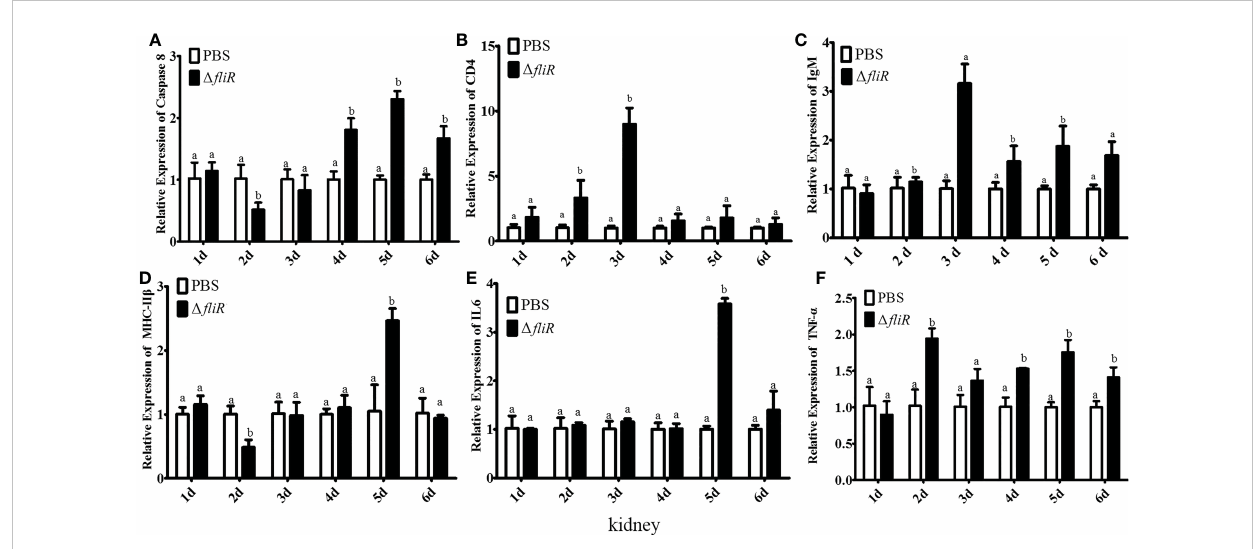
FIGURE 10 The expression levels of immune-related genes in grouper kidney after immunization were detected by qRT-PCR for (A) Caspase8 , (B) CD4 , (C) IgM , (D) MHC-II b , (E) IL6 , (F) TNF- a . Groups with notable differences are labeled with different letters above the bars. b -actin was chosen as the reference gene. Data are shown as mean ± SEM (n =